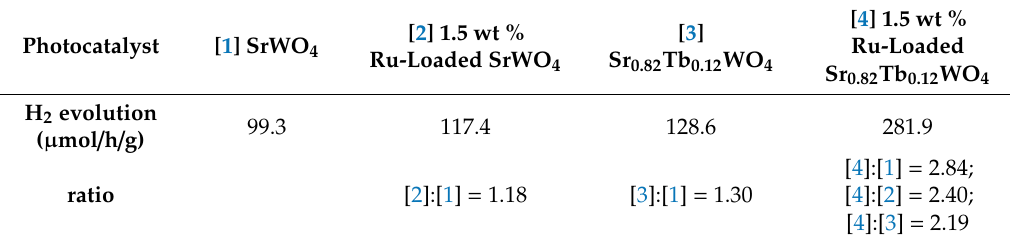
Table 1. The photocatalytic H 2 evolution of four samples in 5 vol % TEOA under UV light. Photocatalyst